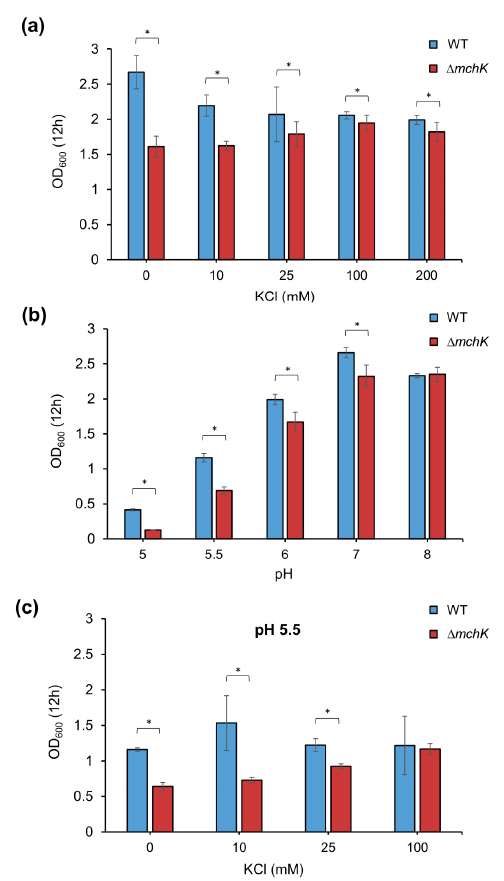
Figure 3. K + effect on the growth of mc 2 155 and its ∆ mchK derivative under different conditions. ( a ) Effect of K + addition (10–200 mM KCl) on the growth of mc 2 155 and ∆ mchK at neutral pH. The ability of high K + concentrations to restore the growth of the ∆ mchK mutant was measured in cultures at mid-exponential phase (12 h). ( b ) Effect of extracellular pH (5–8) on the growth of mc 2 155 and the ∆ mchK mutant in Middlebrook 7H9 liquid medium after 12 h of incubation (initial OD 600 0.05). ( c ) Effect of K + addition (10–100 mM KCl) on the growth of mc 2 155 and ∆ mchK at pH 5.5. The OD 600 was measured after 12 h of incubation at 37 °C. Error bars indicate 95% CI (confidence intervals); (*) p < 0.05 ( t -test).